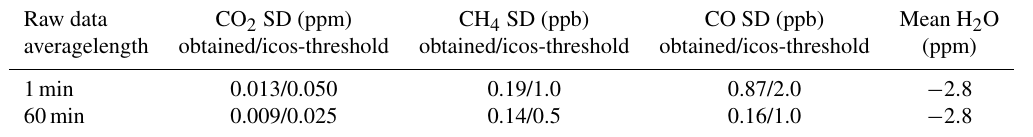
Table 1. Results obtained during the “precision test” (CMR) and ICOS-threshold values for two averaging times (1 and 60min). The standard deviation (SD) reported is of the sample of 1min (or 60min) means obtained through the full duration of the test.